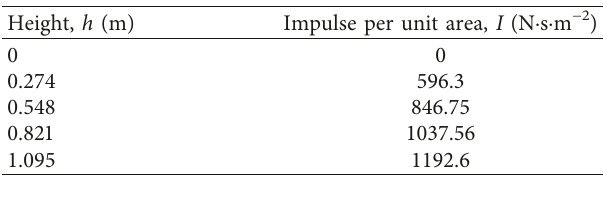
Figure 5: Test case. (a) Global test; (b) local pendulum impact. Table 3: Test load condition.